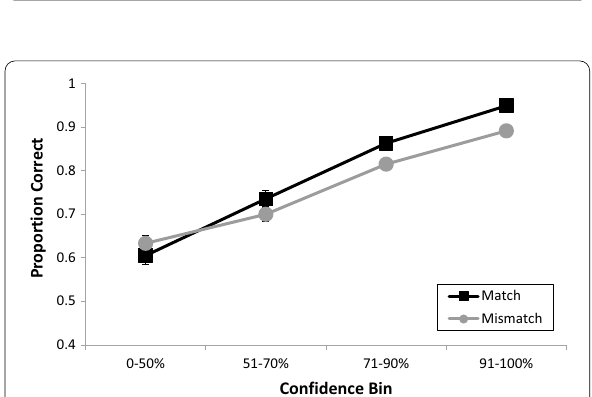
Fig. 12 CAC curves across the four combinations of encoded versus tested face type (Full full face; INT internal features only), with = = standard error bars